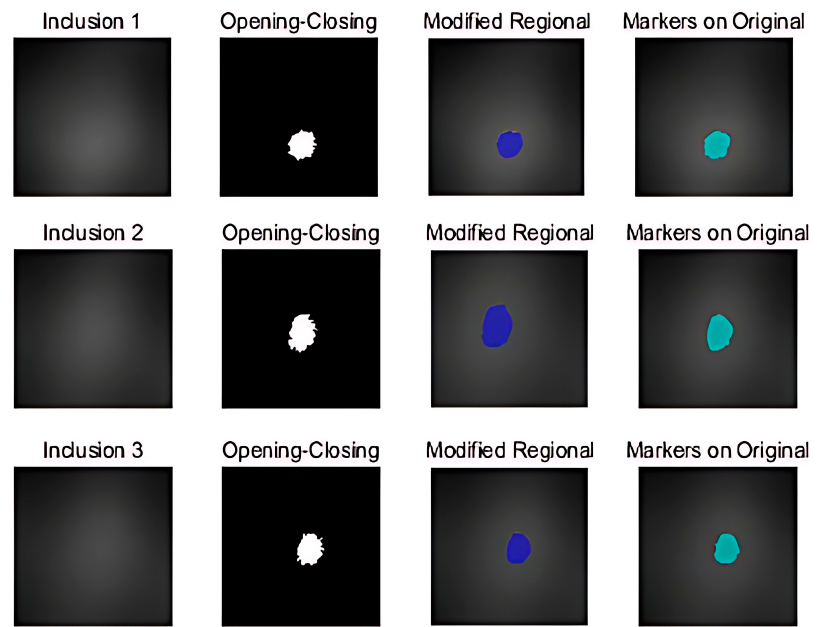
Figure 33. Thyroid-tumor-extraction